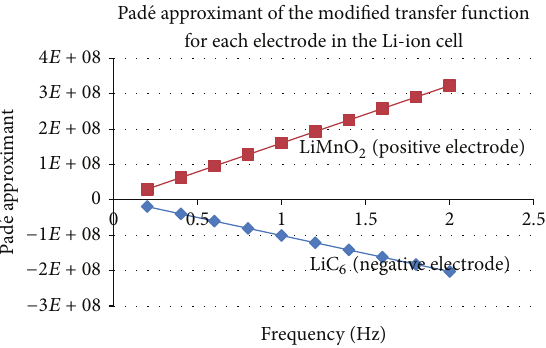
Figure 2: The transfer function has been linearized. The singularity at the origin has been removed. Physically, at higher frequency more lithium ions leave the